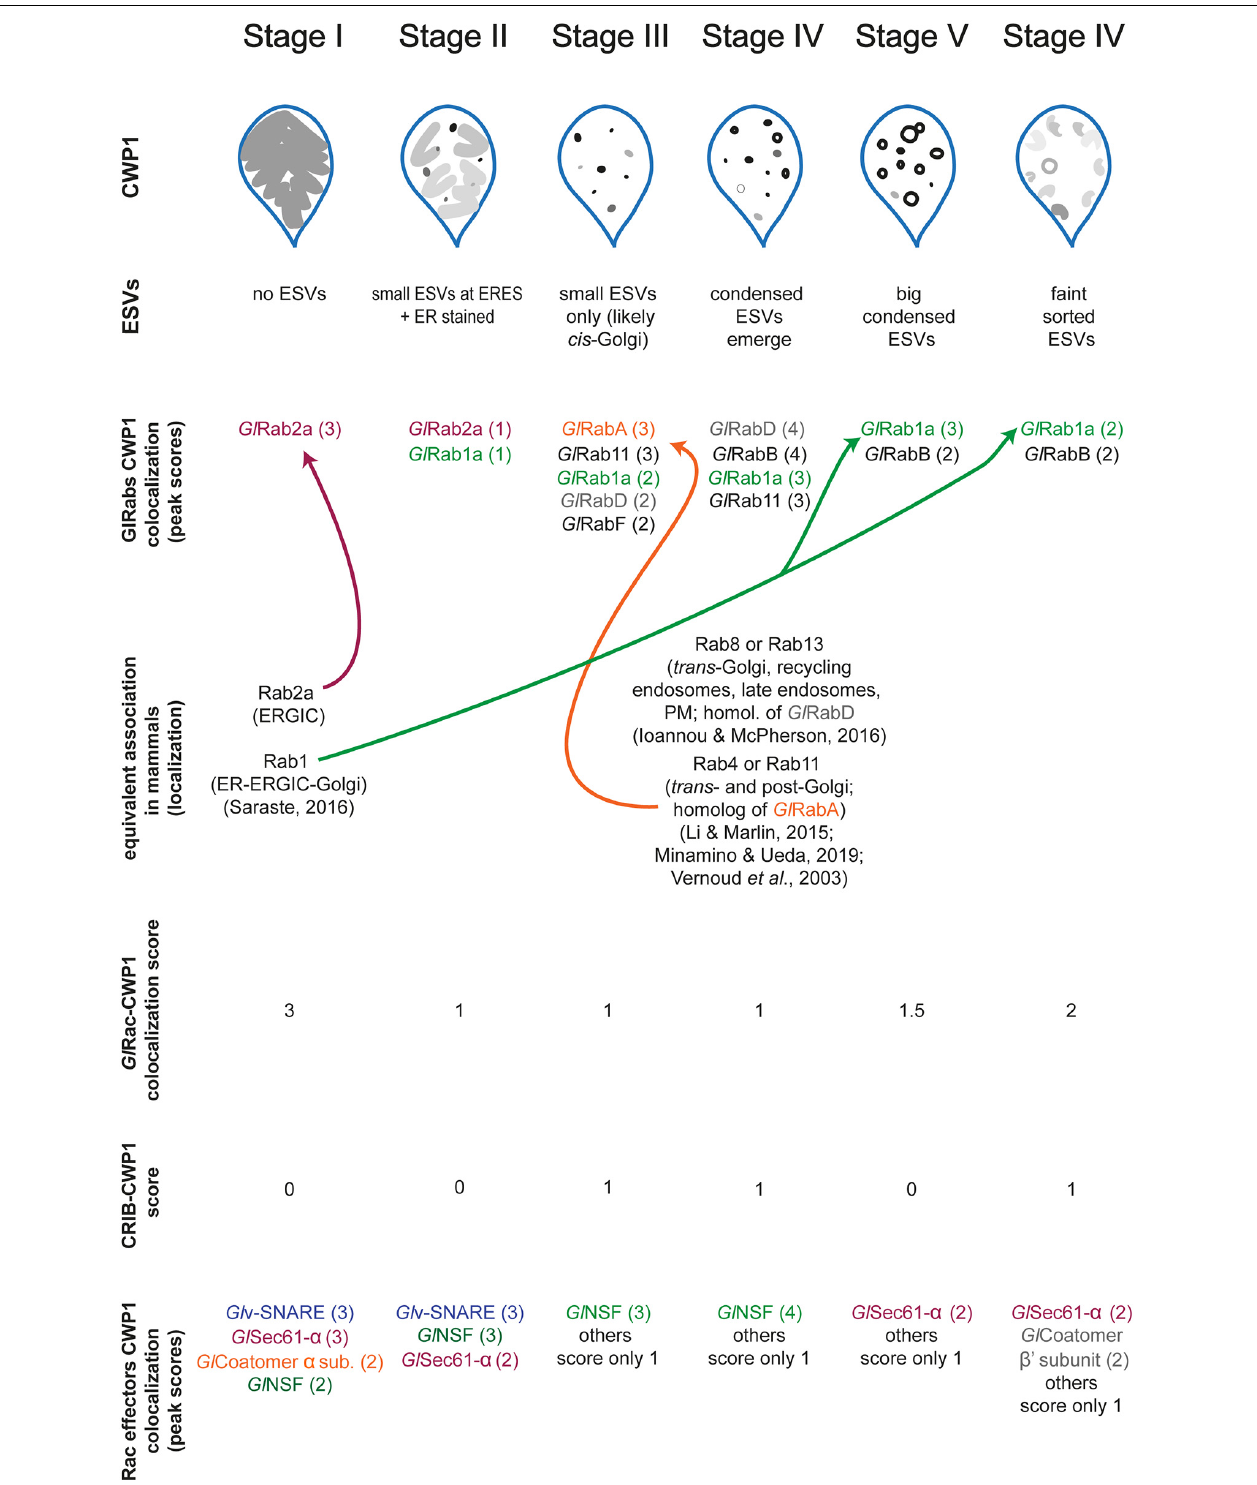
FIGURE 5 | Graphical summary showing the relationship between all proteins studied here relative to ESV stages. Values in parenthesis indicate our qualitative colocalization scores.